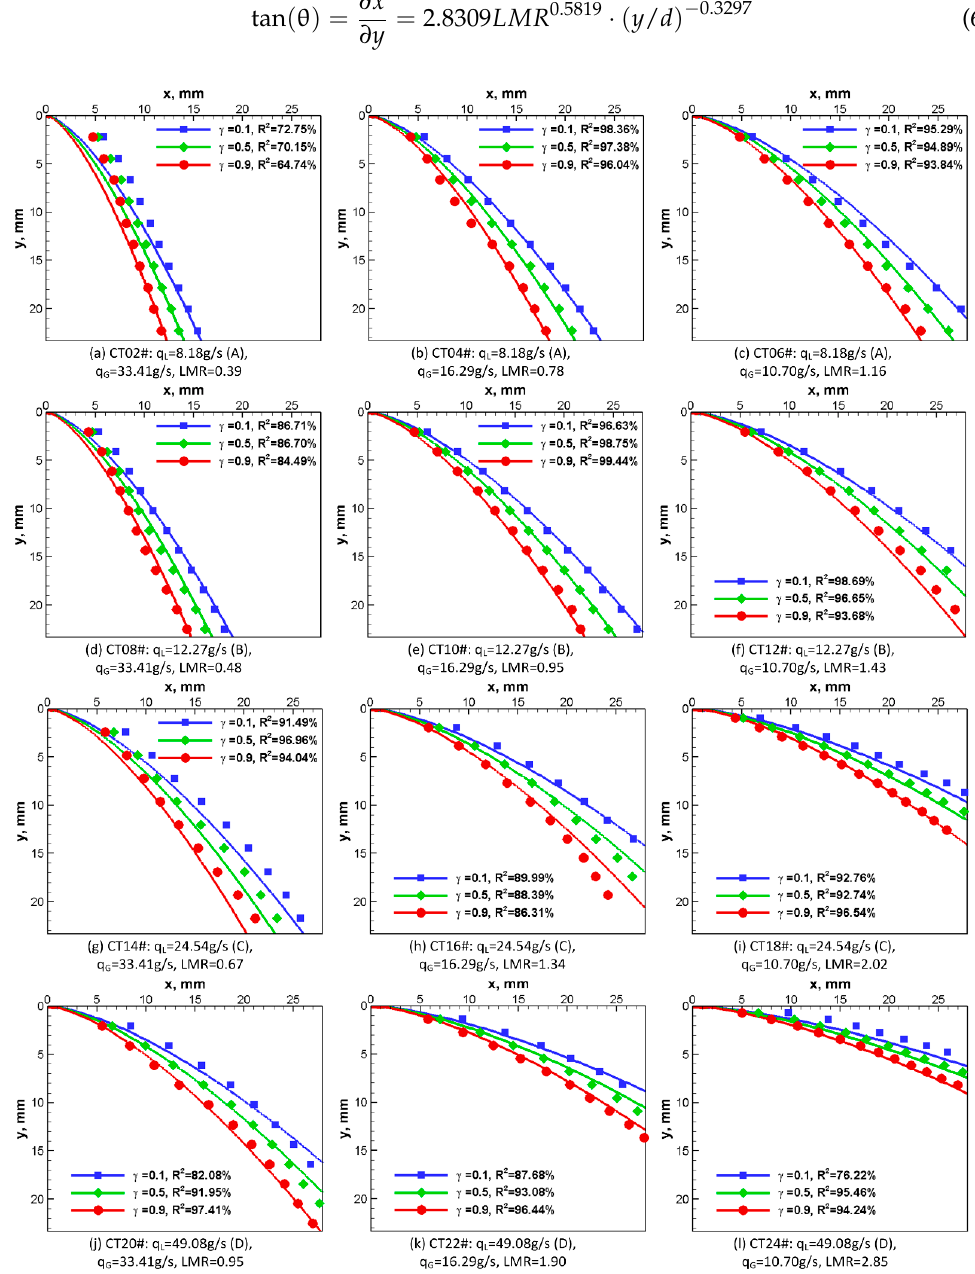
Figure 8. Comparison of the experimental data points and estimated curves for different spray fraction isolines ( γ = 0.1, γ = 0.5, and γ = 0.9).